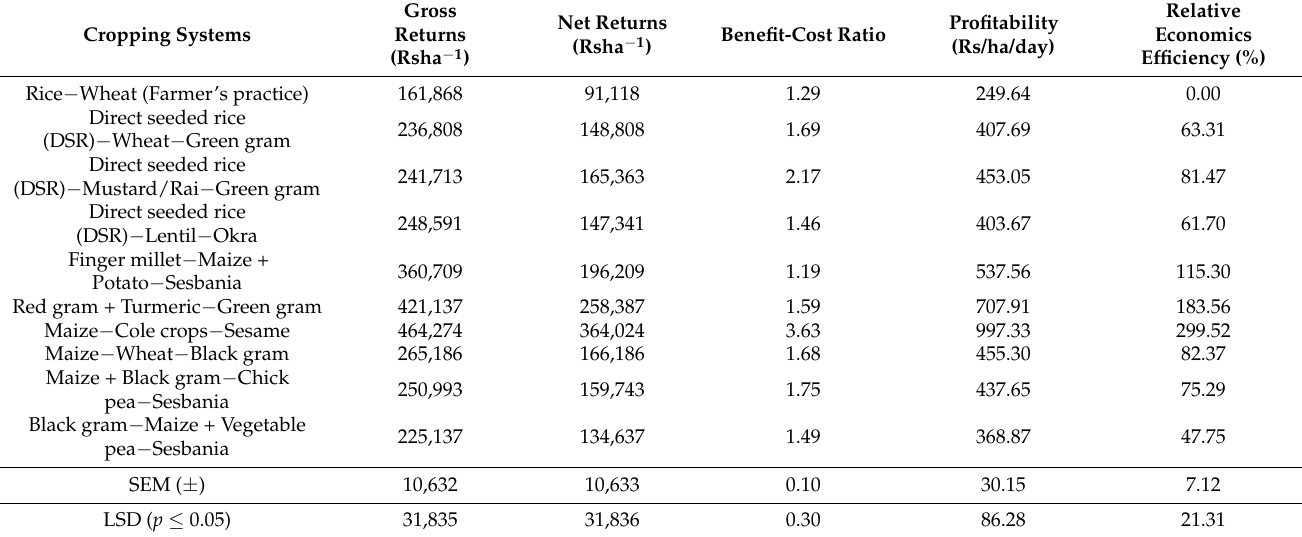
Table 6. Effect of diversification in the rice–wheat cropping system on economics.